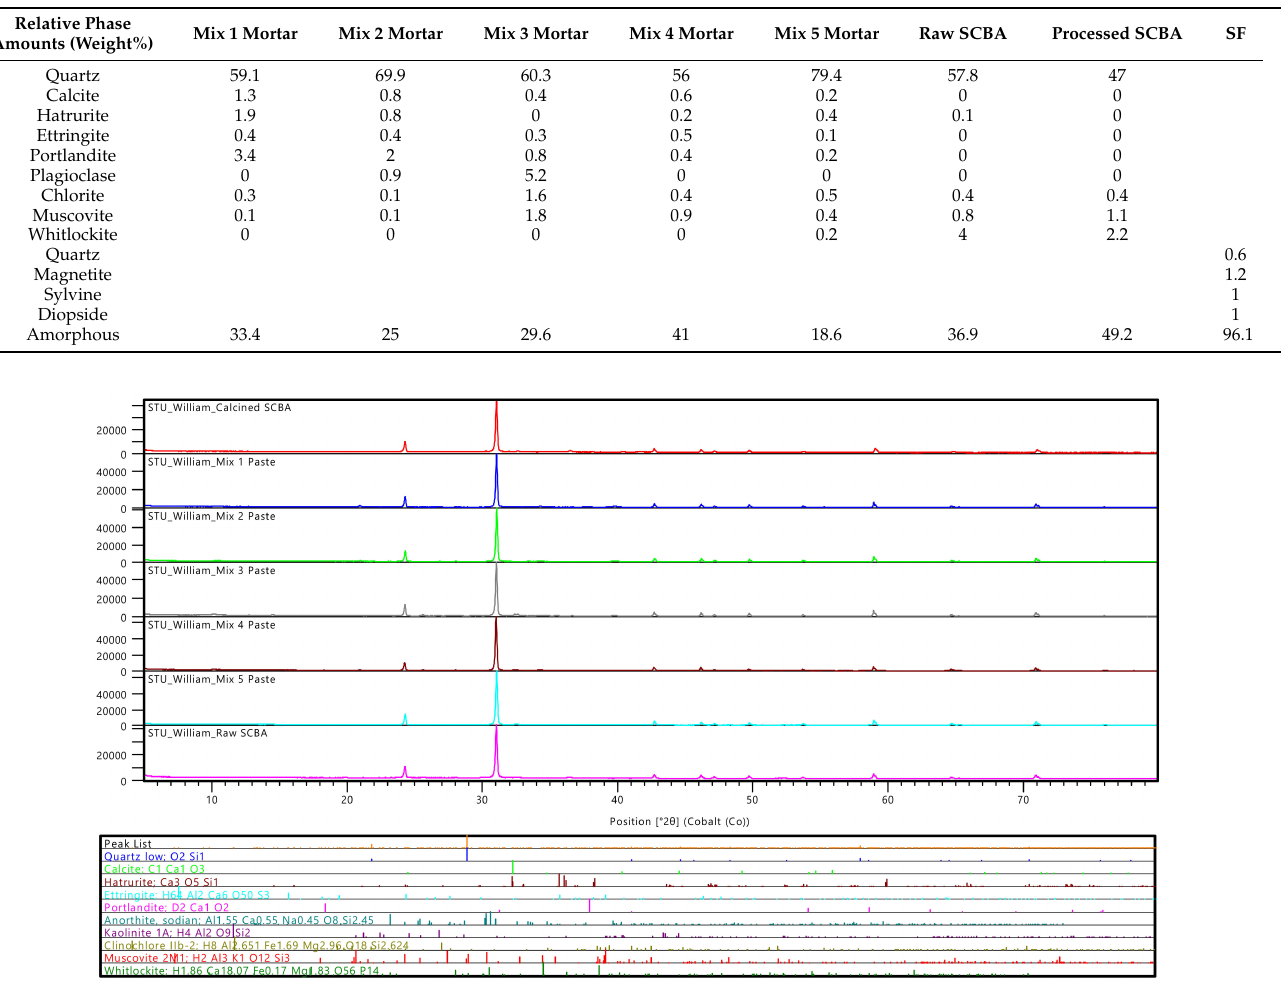
Figure 1. Diffractograms for raw SCBA, processed SCBA, and